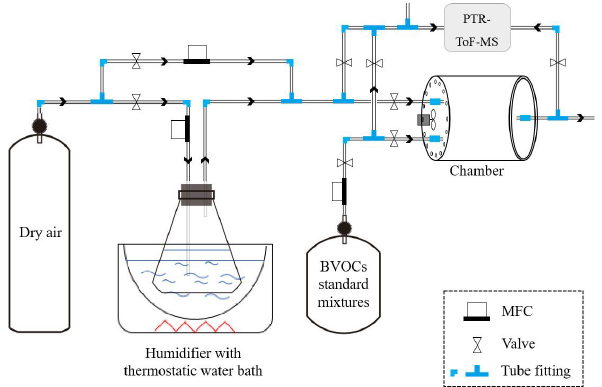
Figure 2. Schematic diagram of chamber characterization exper- iments in the laboratory using standard BVOCs mixture to imitate emissions of BVOCs from branches. MFC stands for mass flow con-